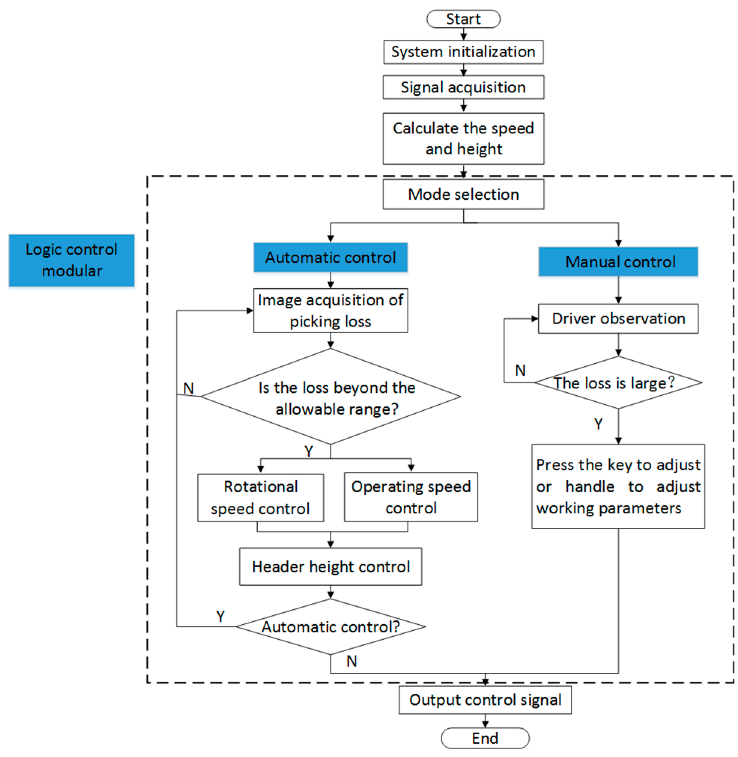
Figure 3. Software structure diagram.